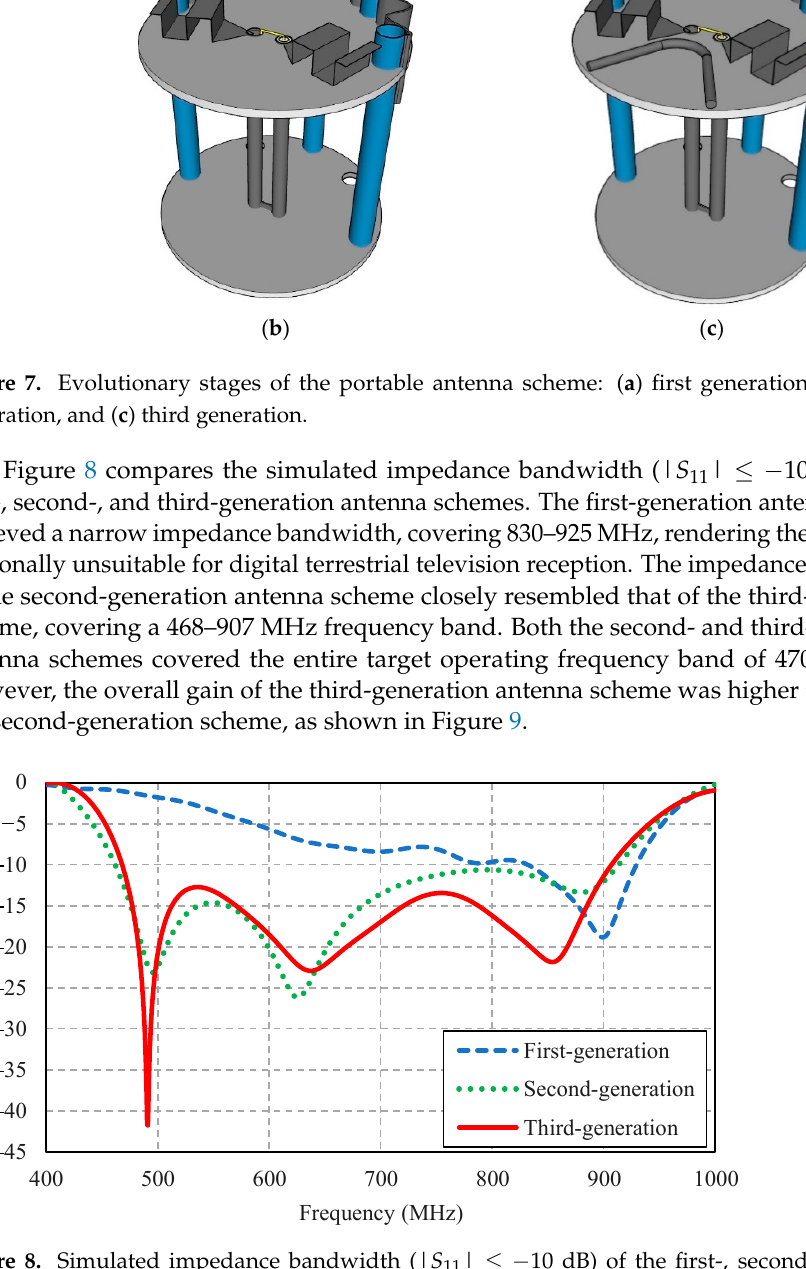
Figure 9. Simulated antenna gains of the first-, second-, and third-generation antenna schemes.